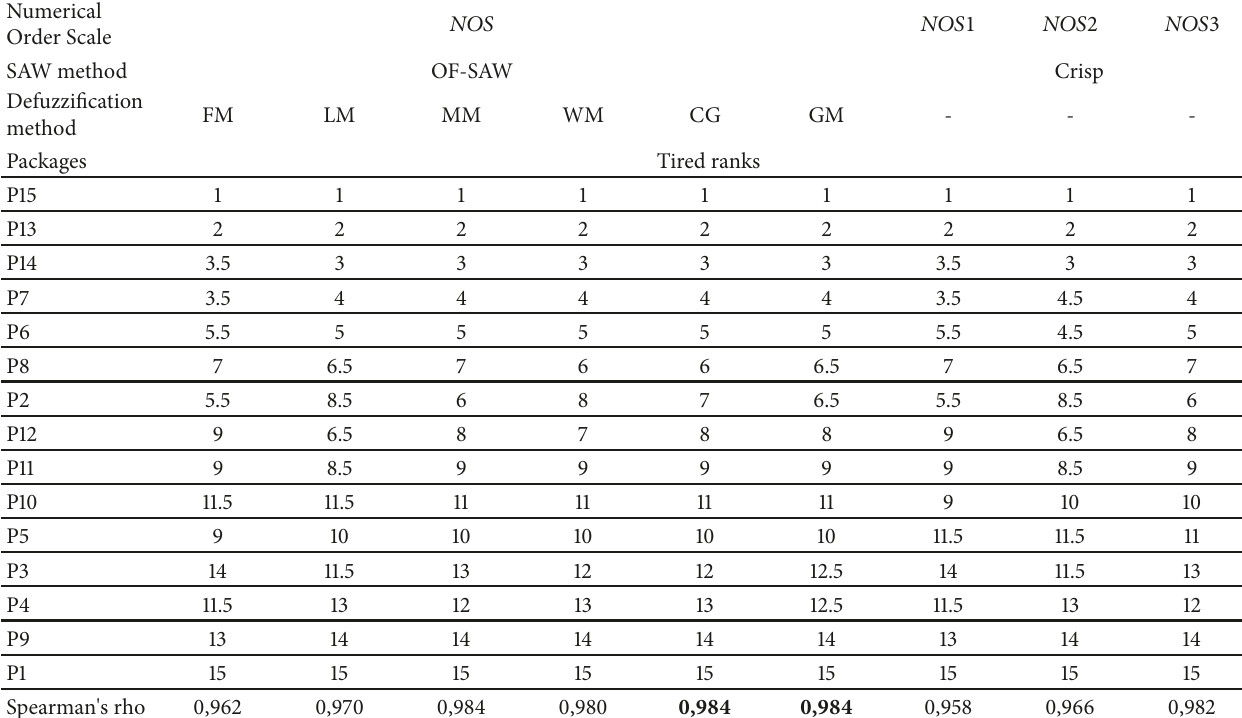
Table 7: The negotiation packages’ rankings determined by SAW